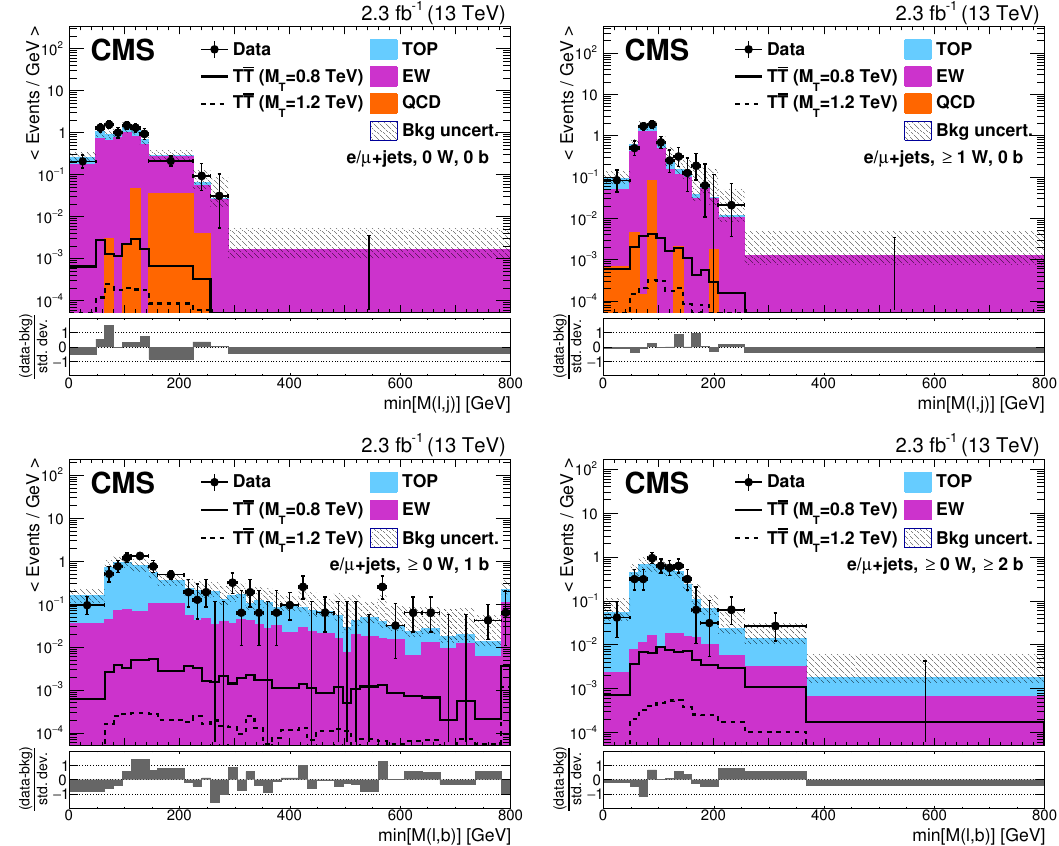
Figure 8 . Distributions of min[ M ( ‘; j )] in the W + jets control region of the boosted W channel (upper) for 0/ (cid:21) 1 W tag categories (left/right), and min[ M ( ‘; b)] in the t(cid:22)t control region of the boosted W channel (lower) for 1/ (cid:21) 2 b tag categories (left/right). Also shown are the distributions of TT signal events with T quark masses of 0.8 and 1.2 TeV. The uncertainty in the background includes the statistical and systematic uncertainties described in section